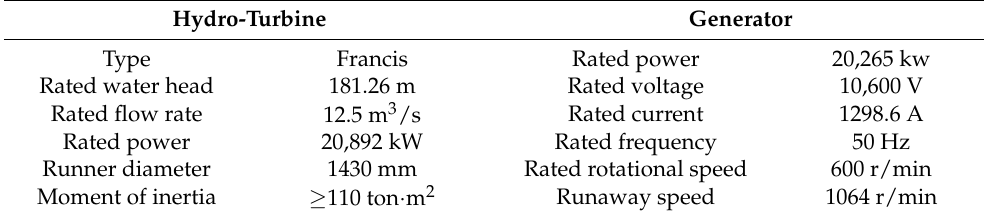
Table 1. Basic parameters of the Hydraulic-Turbine Generator